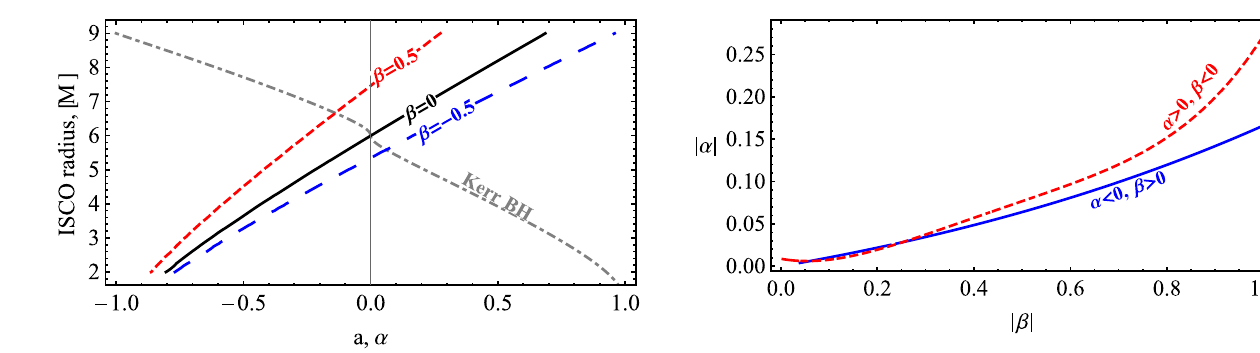
value of MOG parameter at α ∈ ( − 0 . 730477 , − 0 . 562357 ) ( α ∈ ( − 0 . 081132 , 0 . 424942 ) ) for magnetized particles with the magnetic coupling parameters β ∈ ( − 0 . 5 , 0 . 5 ) .